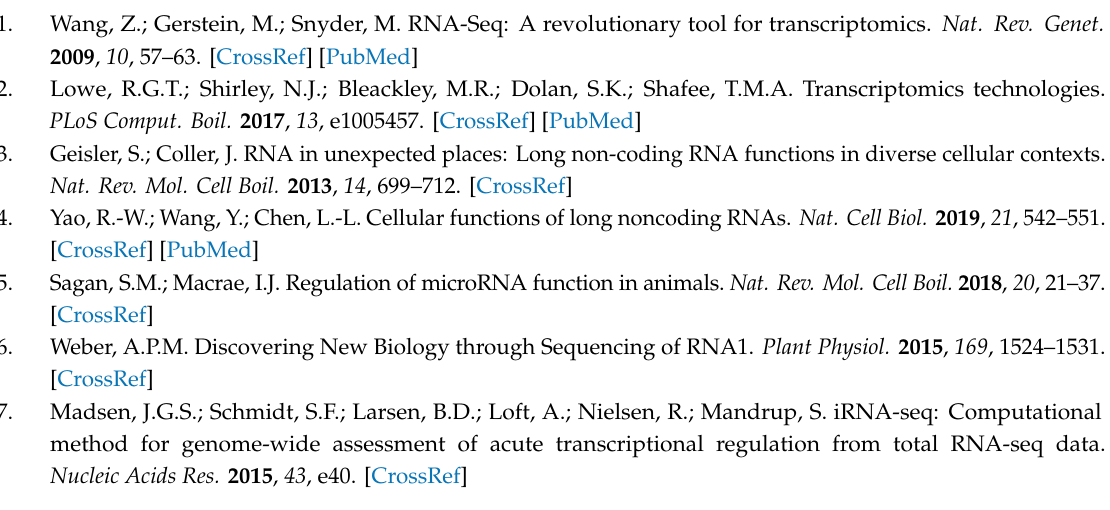
Figure S1. Plots showing raw sequencing QC. Data quality of individual RNA-seq files was analyzed by FastQC. MultiQC was used to generate an all-in-one HTML reports. Shown here are plots from the final HTML report. (A) Scatterplot showing average GC% and total read numbers. (B) The numbers of unique and duplicate reads. (C) Per-base mean read quality scores. (D) Per-sequence quality Scores. (E) Per-sequence GC contents. (F) Sequence duplication rate. (G) Overrepresented sequences. (H) Adaptor contents. Table S1. Comparison of RNA-seq data analysis workflows. Table S2. Software and parameter settings used by the OneStopRNAseq workflow. Table S3. Enriched Gene Ontology (GO) terms related to protein ubiquitination among down-regulated genes by USP7797 treatment compared to DMSO vehicle control. Table S4. Summary of di ff erential alternative splicing events identified by